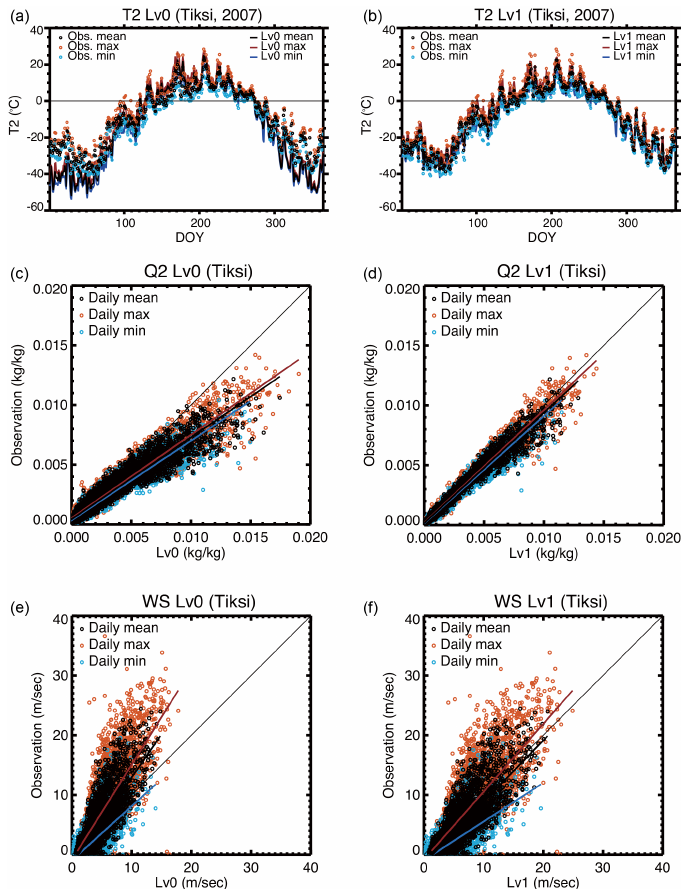
Figure 4. Comparison of GTMIP data with observed values for air temperature (time series in 2007), specific humidity (shown as a scatter plot for all daily data), and wind speed (shown as a scatter plot for all daily data). Examples show the results for level 0 (left column: a , c and e ) and level 1 data (right column: b , d , and f ) at